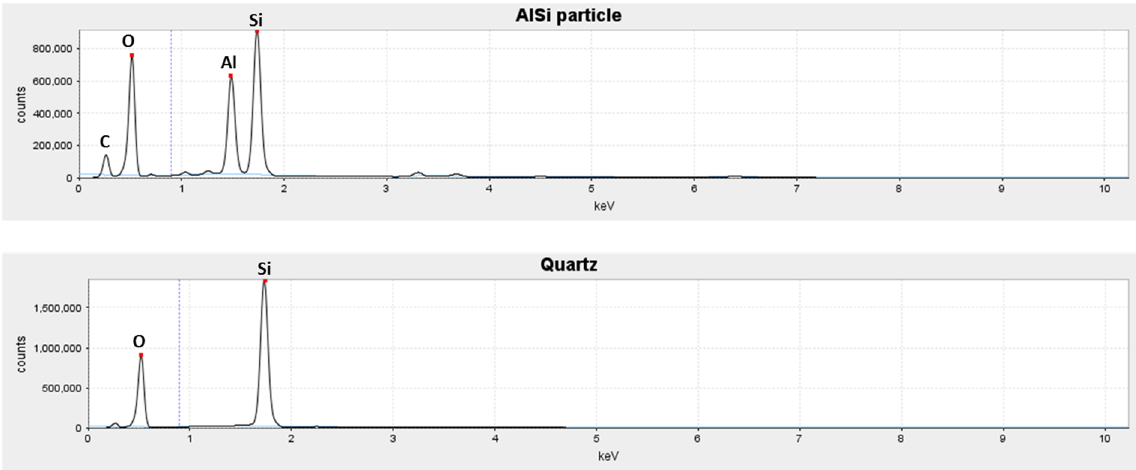
Figure 11. PARC sum spectra for AlSi pixels (blue coloured in the composite map, Figure 12) and Quartz (SiO 2 , yellow coloured in the composite map, Figure 12), indicating the presence of O, Al, and Si by their characteristic X-ray lines.